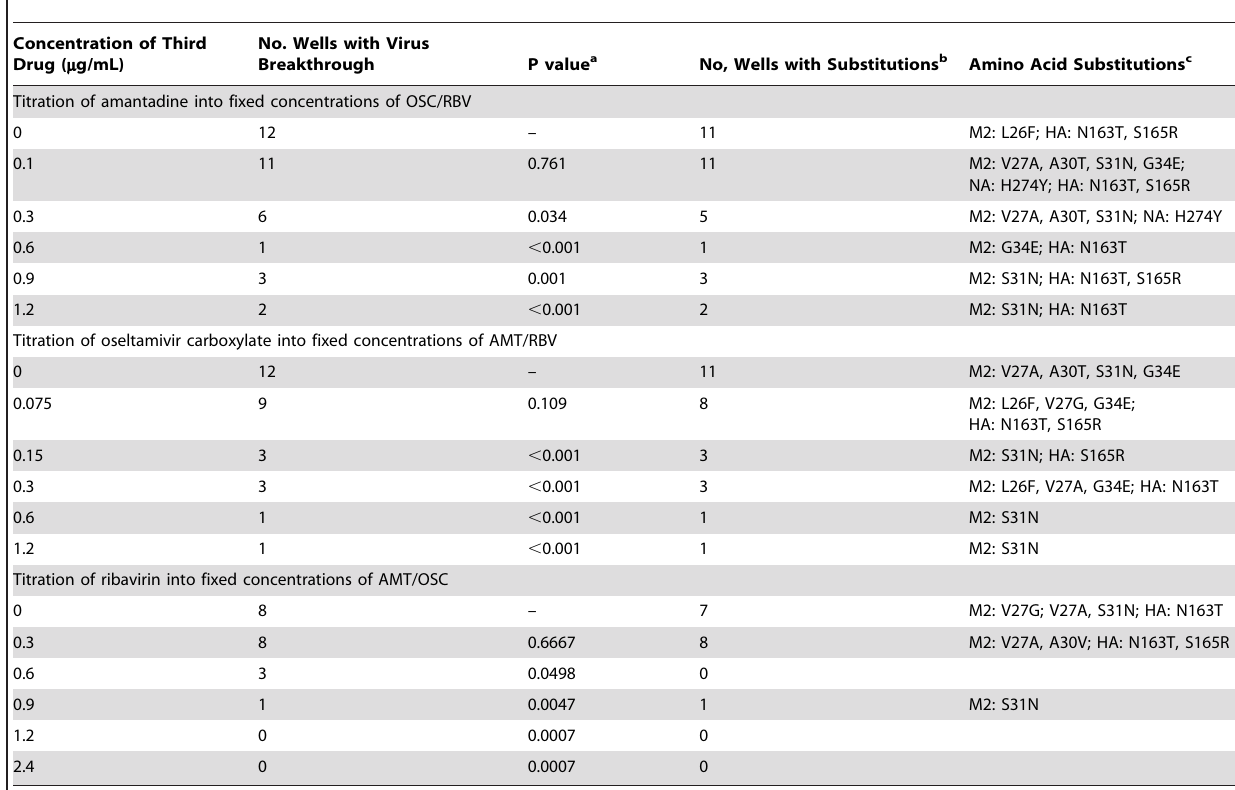
Table 5. Virus Breakthrough and the Presence of Resistance-Associated Substitutions as a Function of the Concentration of the Third Drug in